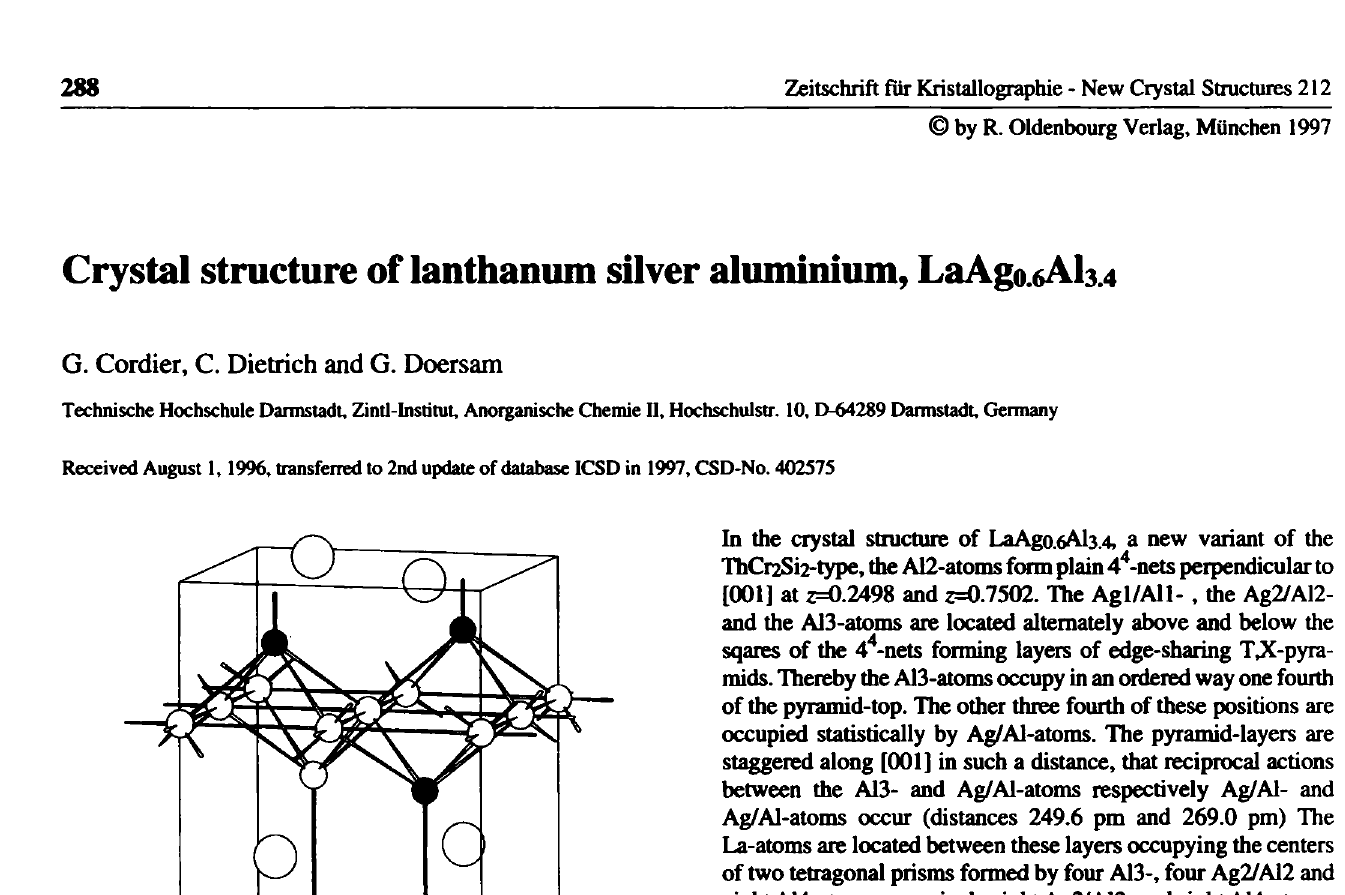
Table 1. Parameters used for the X-ray data collection Crystal: